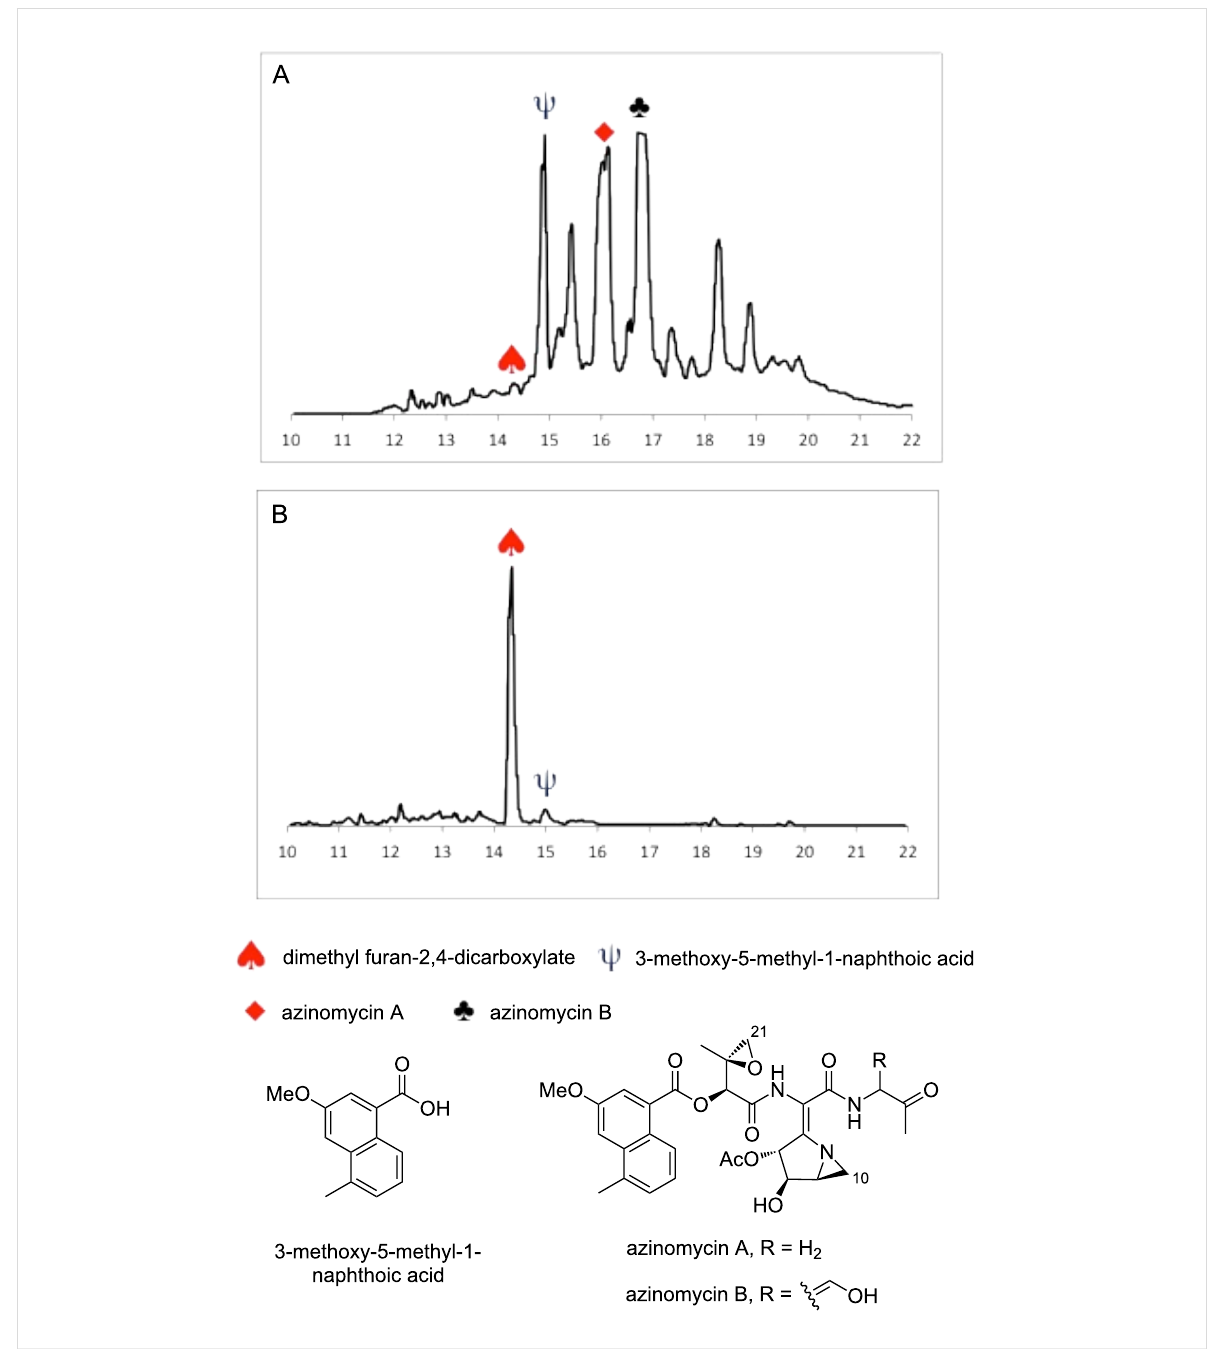
Figure 2: HPLC profiles of (A) S. sahachiroi wild-type and (B) Δ aziA2 crude organic extracts.